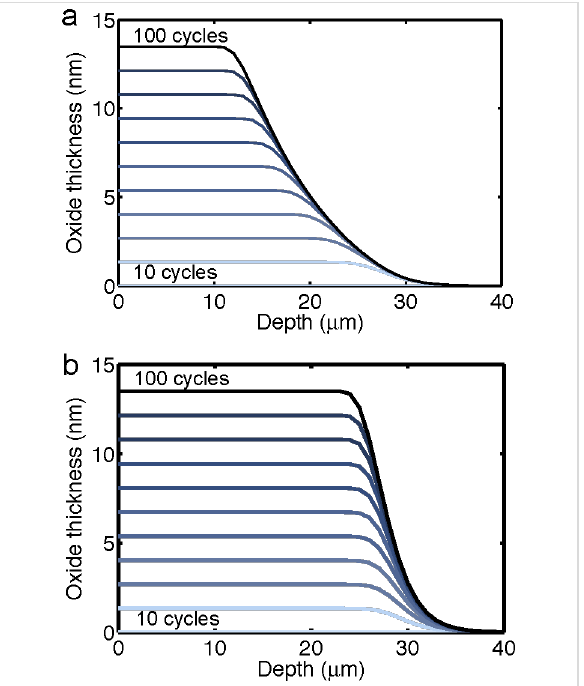
Figure 5: Plot of deposited oxide thickness with respect to the VACNT depth for a multi-cycle ALD process, determined by the model with